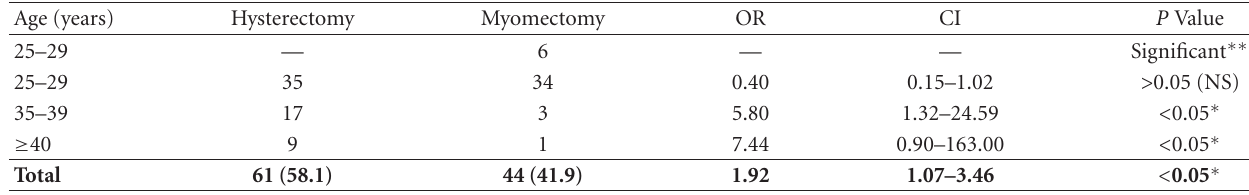
Table 1: Age and type of operation performed.